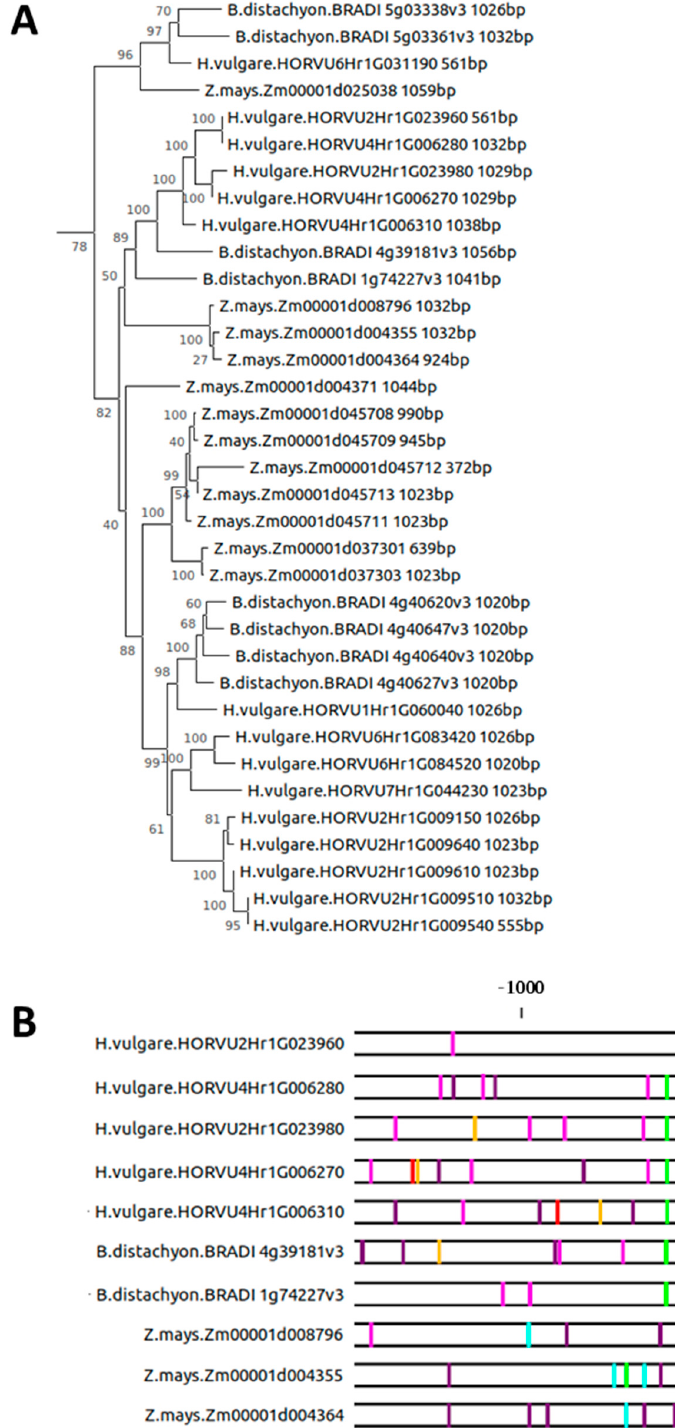
Figure 5. Phylogenic analyses of SAG12 and its promoter region in Brachypodium distachyon , Hordeum vulgare , and Zea mays . ( A ) Phylogeny of SAG12 coding sequence indicating species, gene identification, and sequence length and ( B ) 2000 bp region adjacent to the ATG start codon annotated for the presence of W-boxes (T/C TGAC T/C), A-boxes (TACGTA), T-boxes (AACGTT), C-boxes (GACGTA), and G-boxes (CACGTA). W-boxes in sense (Pink), W-boxes in anti-sense (Purple), A-boxes (Green), T-boxes (Cyan), C-boxes (Yellow), and G-boxes (Red). Due to the large number of sequences, we have only shown one of the three main branches of the phylogenetic tree that has at least two copies of the gene in each